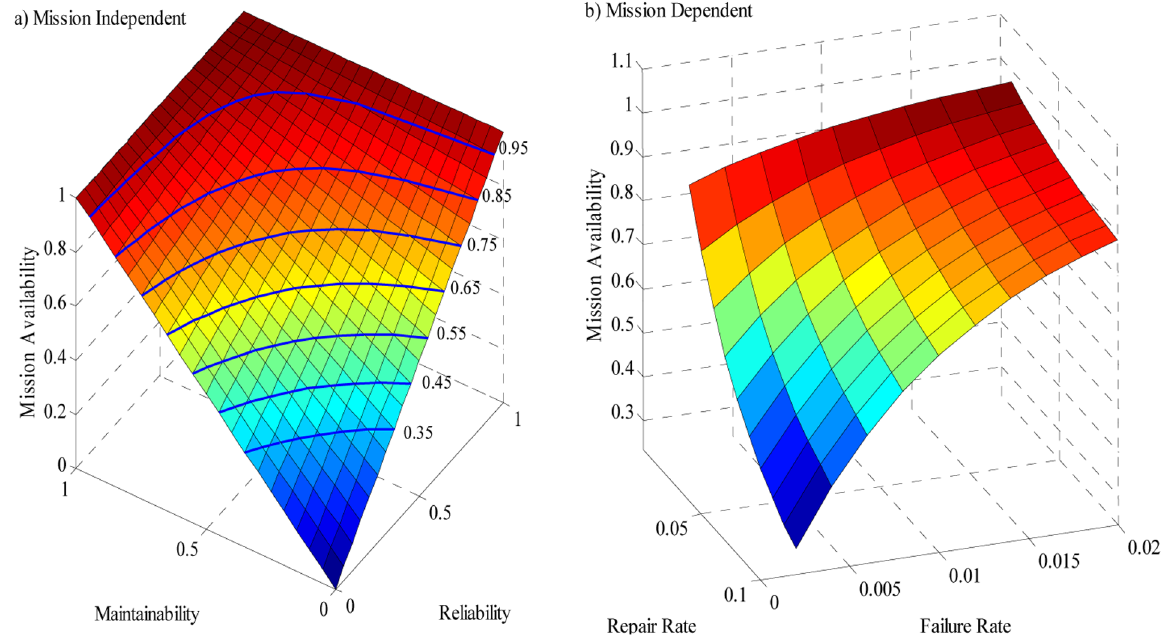
Figure 5. Relationship among mission availability, reliability and maintainability. (a) Scenario 1: Mission independence. The highlighted curves are the equal-availability curves with the availability values 0.35(0.1)0.95. (b) Scenario 2: Mission dependence. With exponential reliability rate